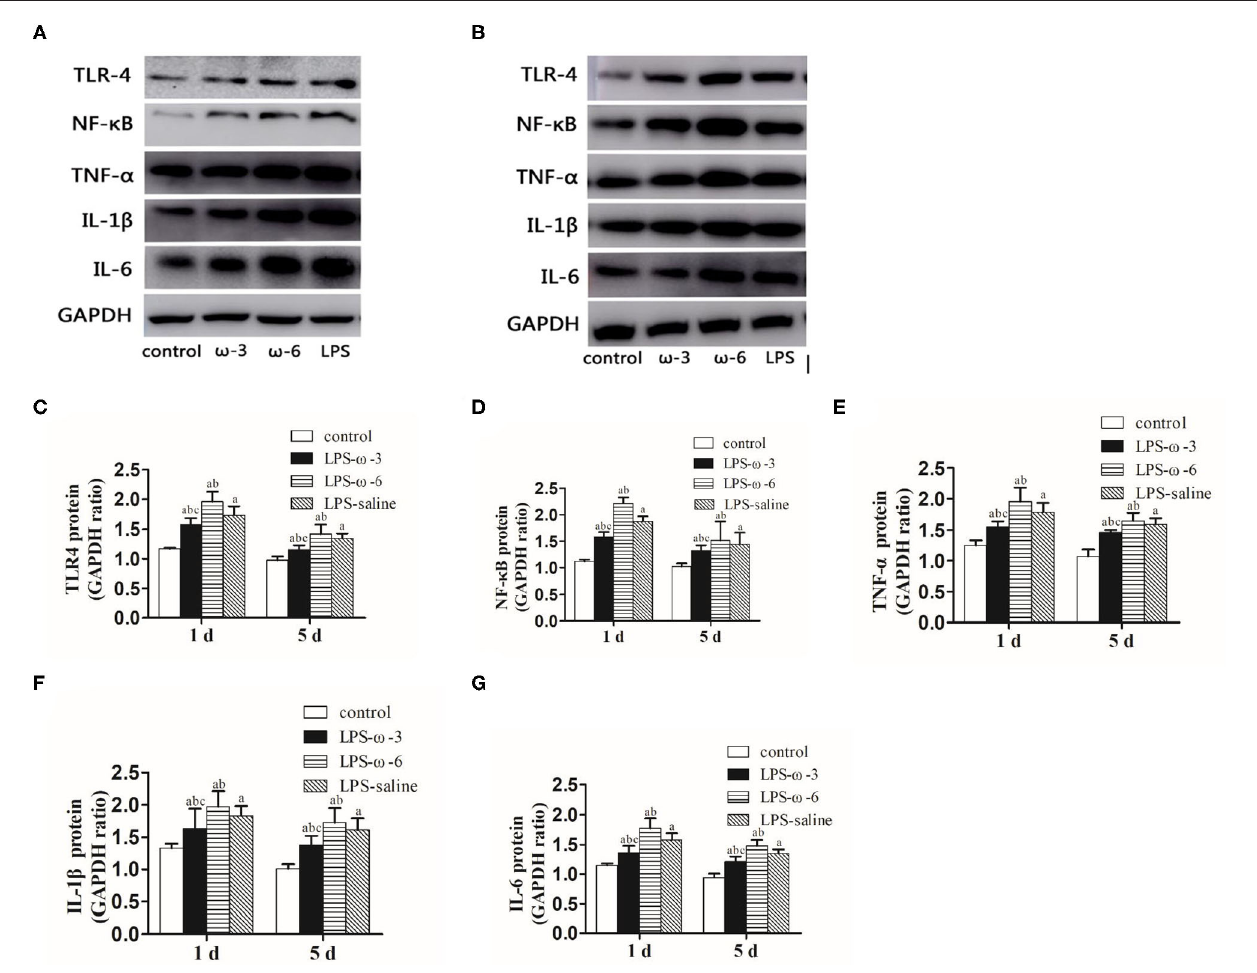
FIGURE 2 | Protein expression of inflammation-related genes. (A) Western blot results showing the TLR4, NF- κ B, TNF- α , IL-1 β , and IL-6 proteins in the hippocampus in neonatal rats from the four groups 1 day after the intraperitoneal injection of drugs. (B) Western blot results showing the TLR4, NF- κ B, TNF- α , IL-1 β , and IL-6 proteins in the hippocampus in neonatal rats from the four groups 5 days after the intraperitoneal injection of drugs. Western blot analysis was performed to determine the protein expression of TLR4 (C) , NF- κ B (D) , TNF- α (E) , IL-1 β (F) , and IL-6 (G) protein expression in the hippocampus in neonatal rats from the different groups. The data points represent the mean ± SD; n = 12 ( a P < 0.05 compared with the control group; b P < 0.05 compared with the LPS group; c P < 0.05 compared with the ω -6